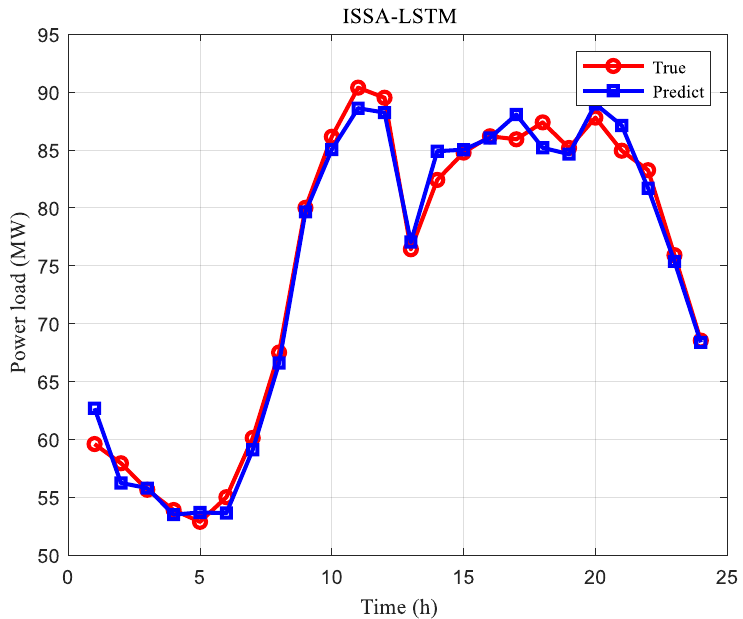
Figure 12. Comparison of ISSA-LSTM model-prediction curves and real values of power load.